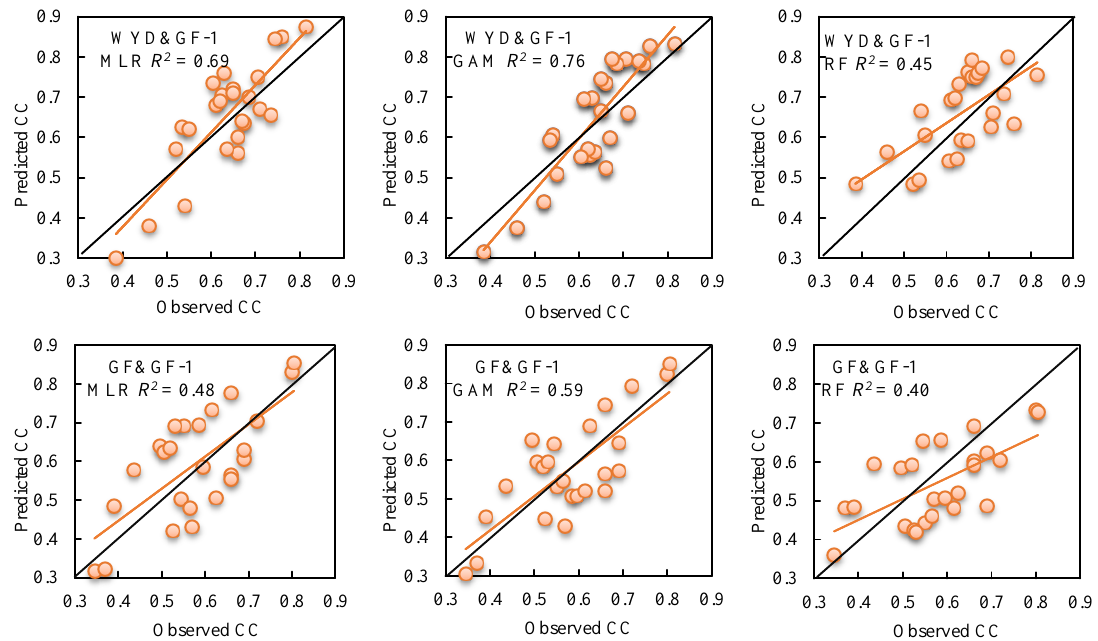
Figure 2. Scatter plot of measured values of canopy closure (CC) and predicted values of the optimal model. Note: The black solid line in the figure is the y = x straight line, and the orange straight line is the linear regression fitting line between the measured and predicted values. WYD—Wangyedian Forest Farm, GF—Gaofeng Forest Farm, GF-1—China Gaofen-1 satellite, RF—Random Forest, MLR—Multiple Linear